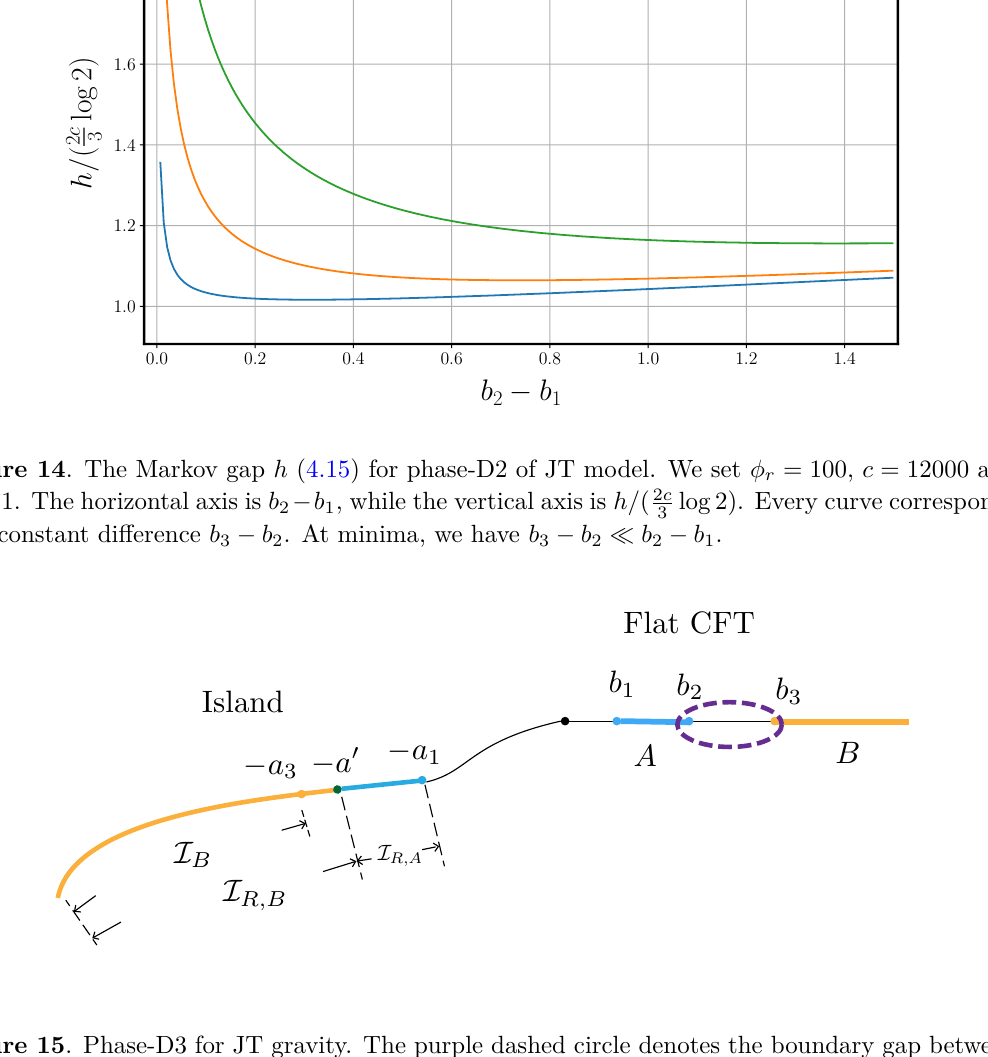
Figure 15 . Phase-D3 for JT gravity. The purple dashed circle denotes the boundary gap between A ∪ I R,A and B ∪ I R,B . a 0 denotes the island